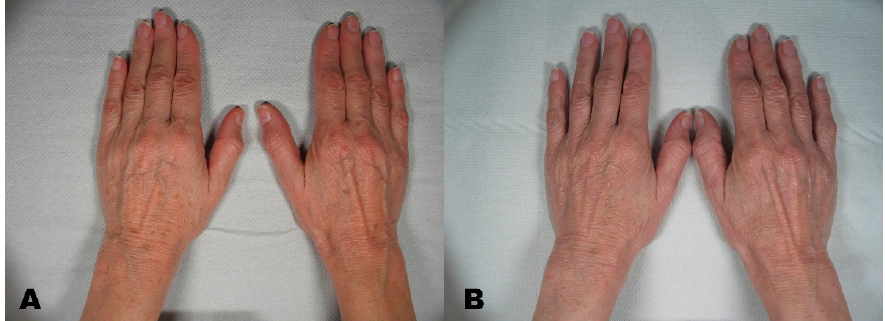
Figure 2. ( A ) Multiple lentigo before treatment. ( B ) region three months after the last session.